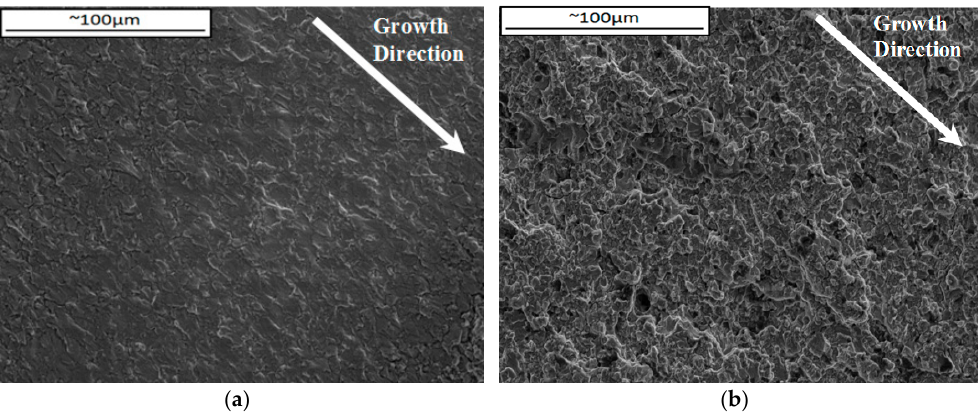
√ m test in ( a ) ACW and